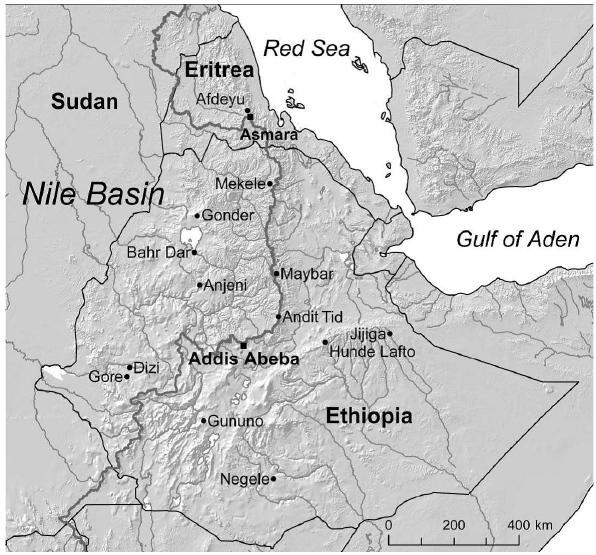
Fig. 1. Map of SCRP research stations (ETHIO-GIS,